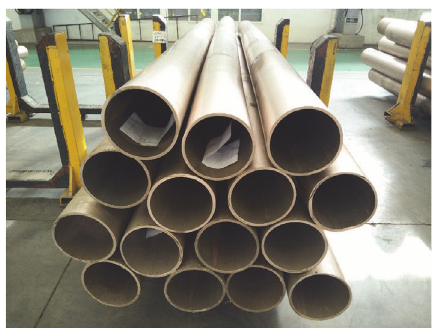
Figure 19: Real product of large diameter cupronickel alloy